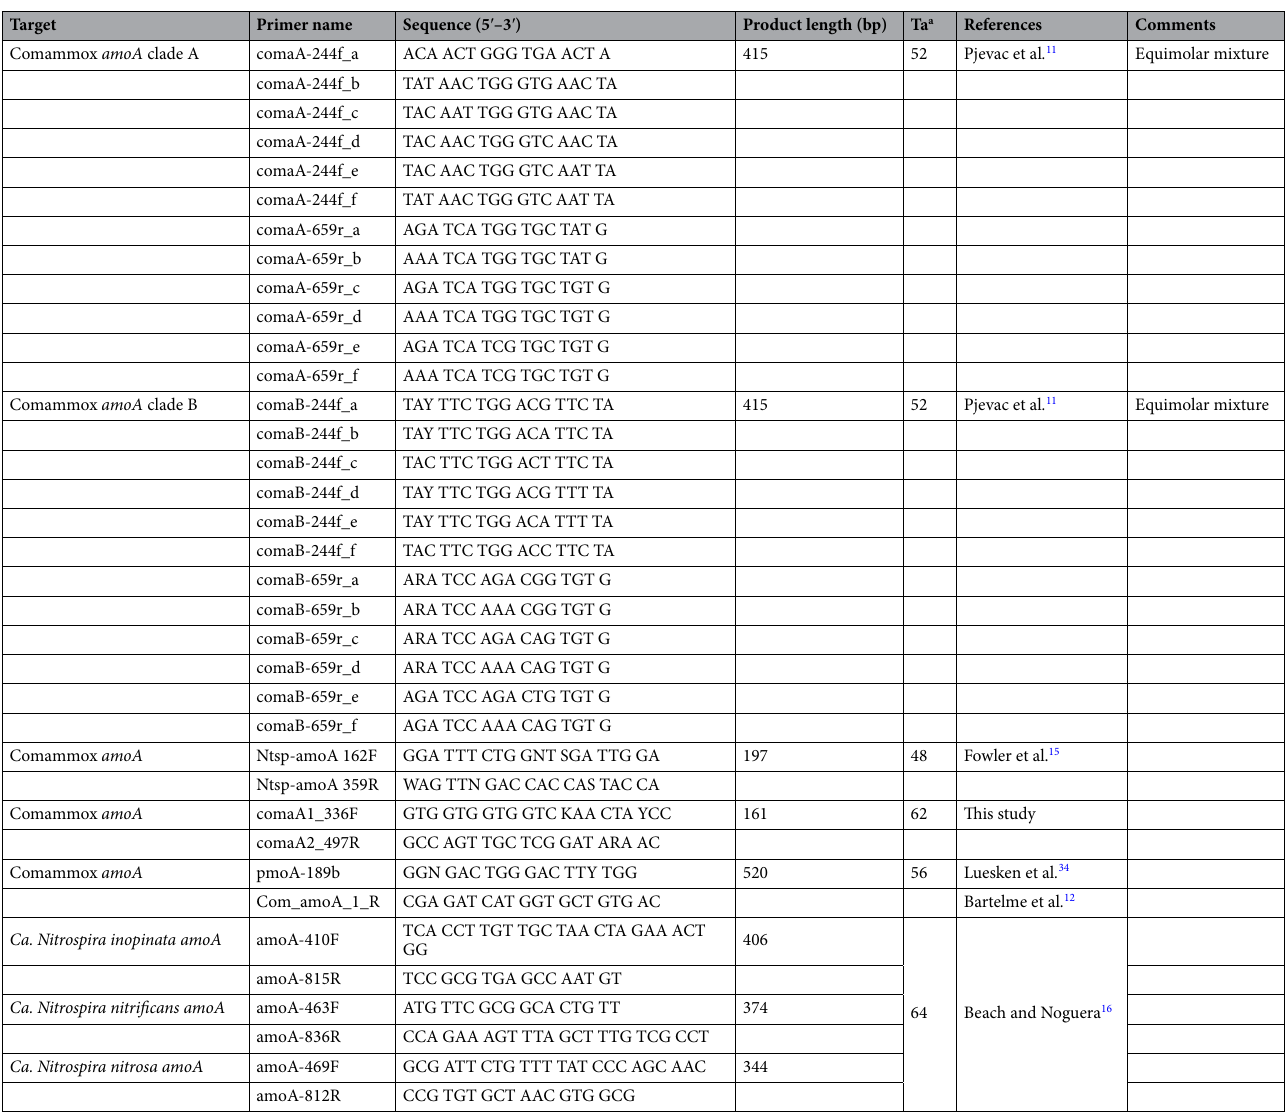
Table 1. Specification of primers used for Comammox amoA detection and quantification. a Ta: Annealing temperature